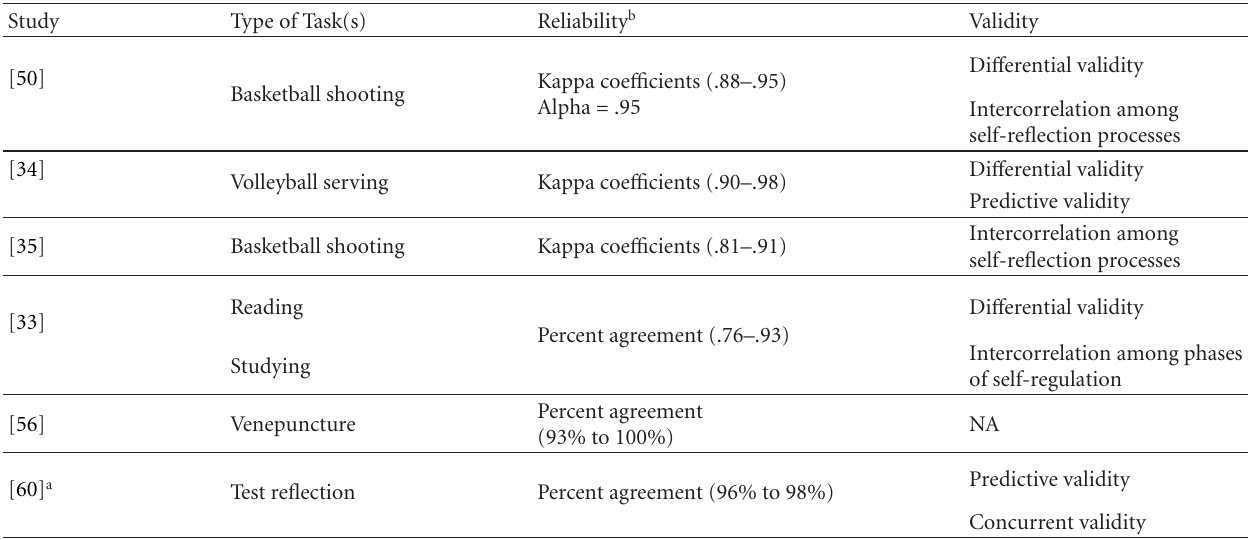
Table 7: General overview of reliability and validity of SRL microanalytic